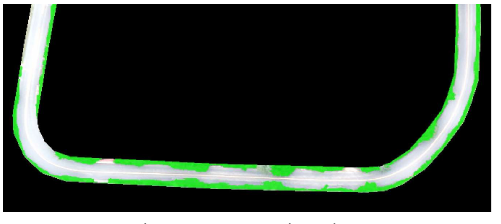
Figure 5. Vegetation